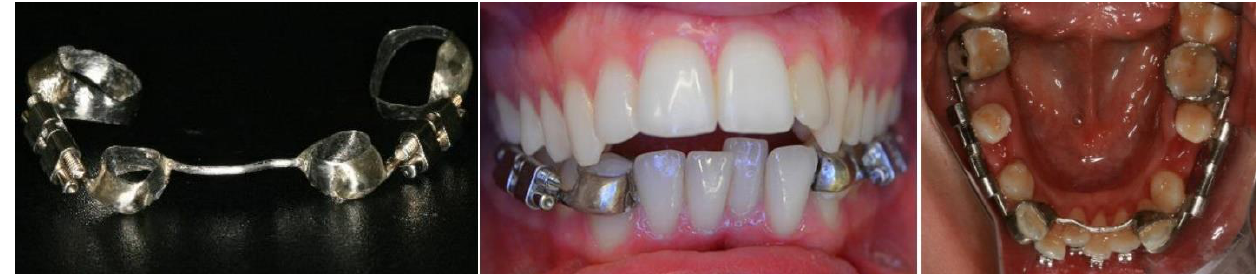
Figure 3. TB distractor with manual activation for reconstruction of mandibular retrognathia [45].